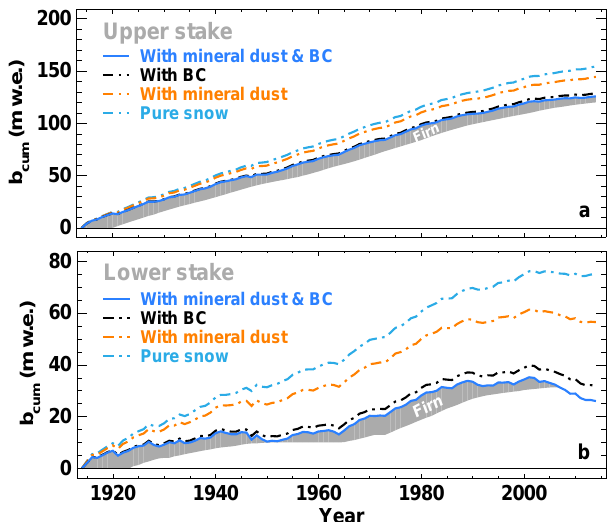
Figure 6. Mean annual absorption (optical depth) of mineral dust and BC over the period 1914–2014 for (a) the upper and (b) the lower stake. The optical depth is calculated as product of mass ab- sorption coefficient of BC/Fe oxides and the corresponding loading in the snow surface layer (top 2cm).